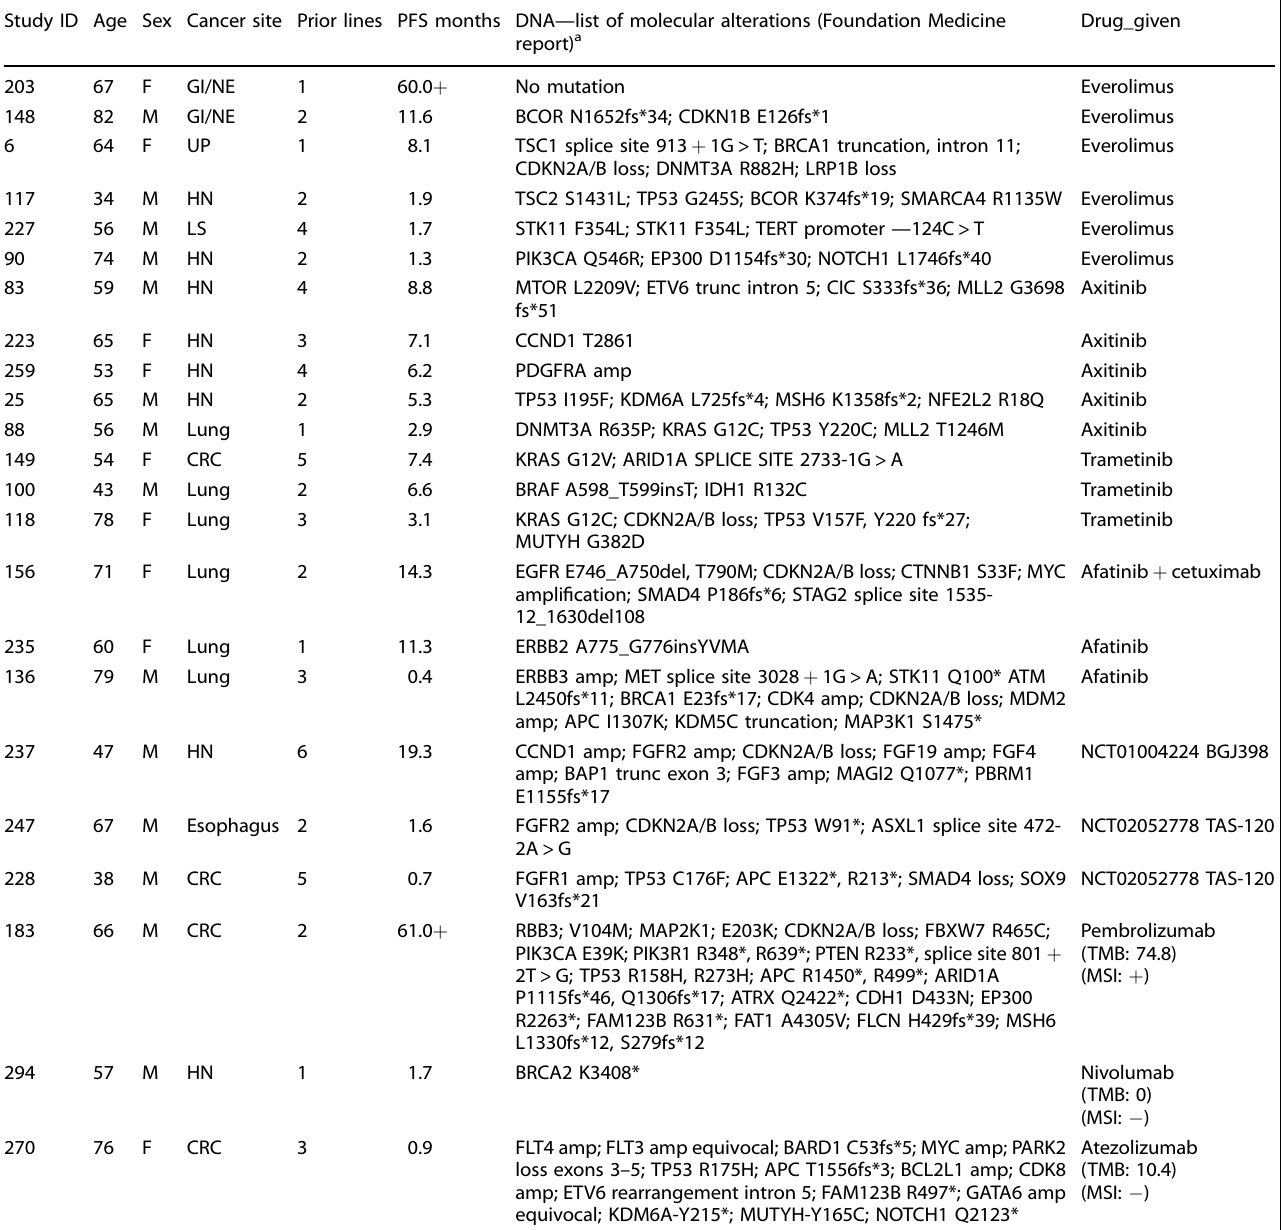
Table 1. Characteristics of the patients treated in WINTHER trial investigated with